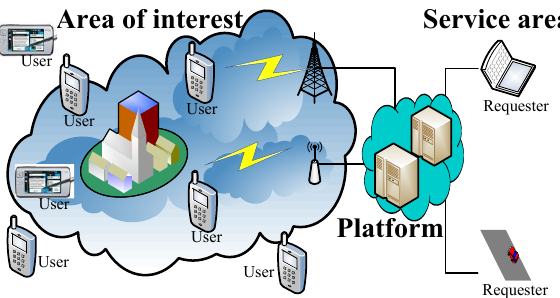
Figure 1. Our crowdsensing system